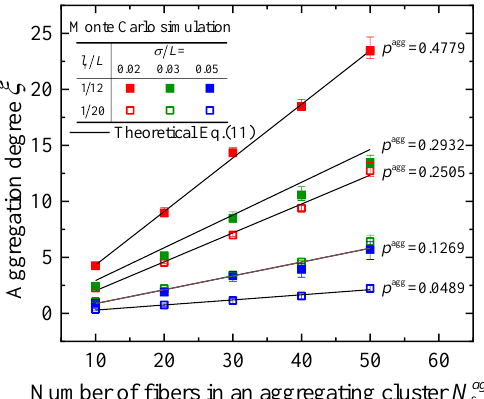
Figure 4. A comparison between the aggregation degree obtained by theory and Monte Carlo simulations (error bars represent the maximum and minimum values of 80 different samples).